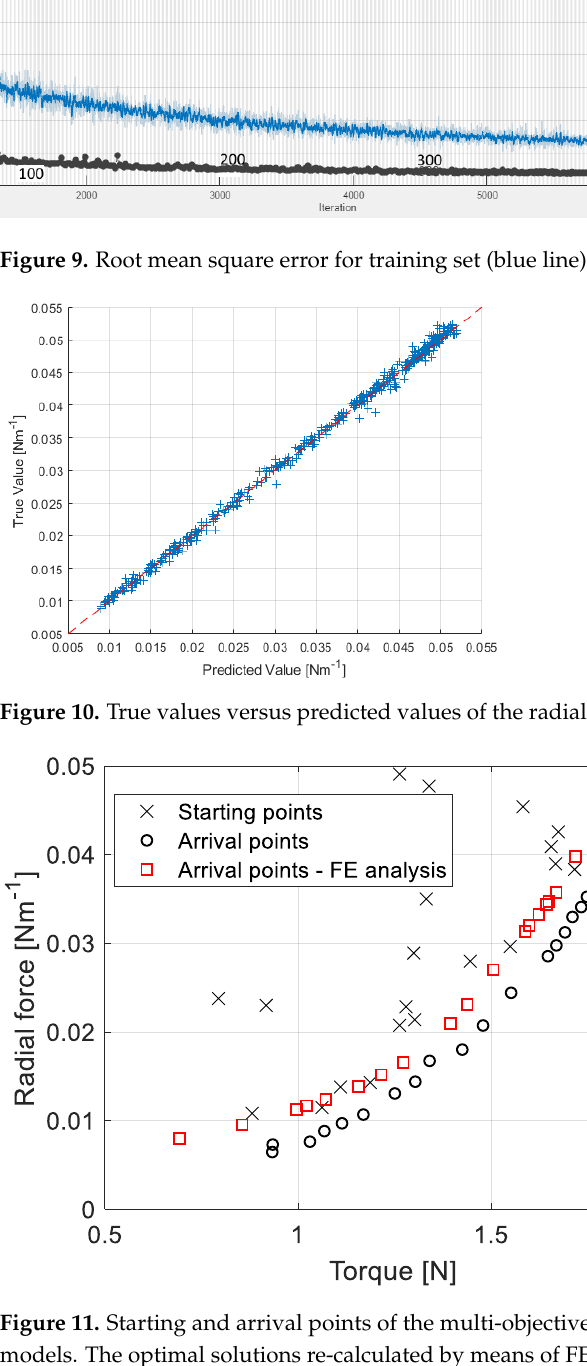
Figure 11. Starting and arrival points of the multi-objective optimization based on CNN surrogate models. The optimal solutions re-calculated by means of FEAs are highlighted with red squares.